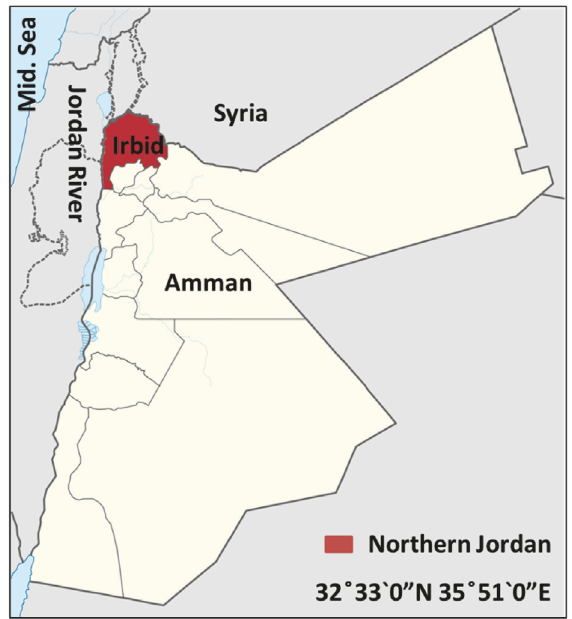
Figure 1: Map of Jordan showing the geography of the study area.